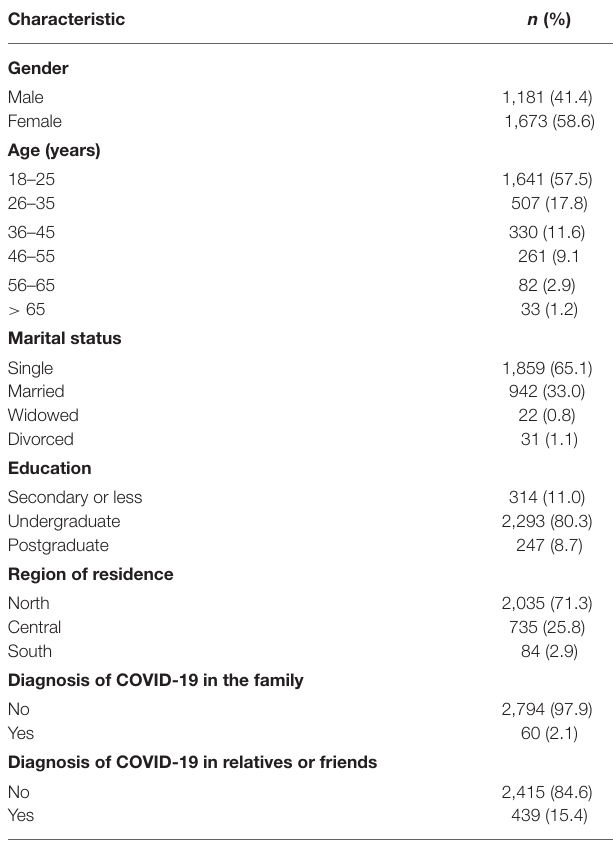
TABLE 1 | Socio-demographic characteristics of the study population ( n = 2854).